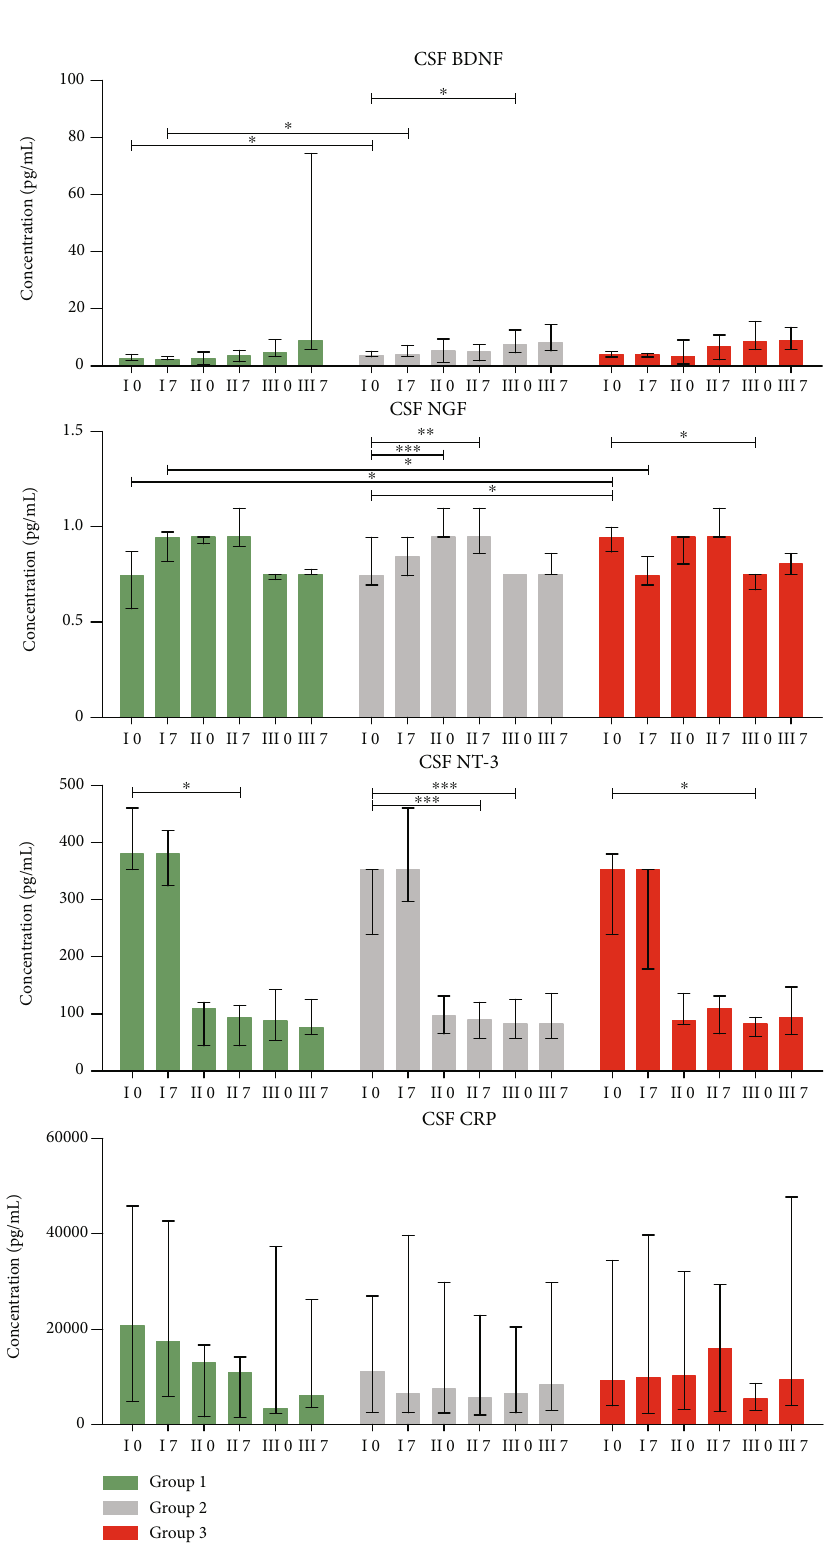
Figure 4: Concentrations of analyzed factors in CSF (pg/mL) of 42 sALS patients divided into three groups, based on the FDA scale results. The samples were collected in six timepoints presented on the x -axis. Roman numerals represent each Lin − cell administration (I, II, and III), and Arabic numbers stand for the day of sample collection (0 and 7). Data are presented as the median values with an interquartile range. Level of signi fi cance: ∗ p < 0 : 05 , ∗∗ p < 0 : 01 , and ∗∗∗ p < 0 : 001 . BDNF: brain-derived neurotrophic factor; NGF: nerve growth factor; NT-3: neurotrophin 3; CRP: C-reactive